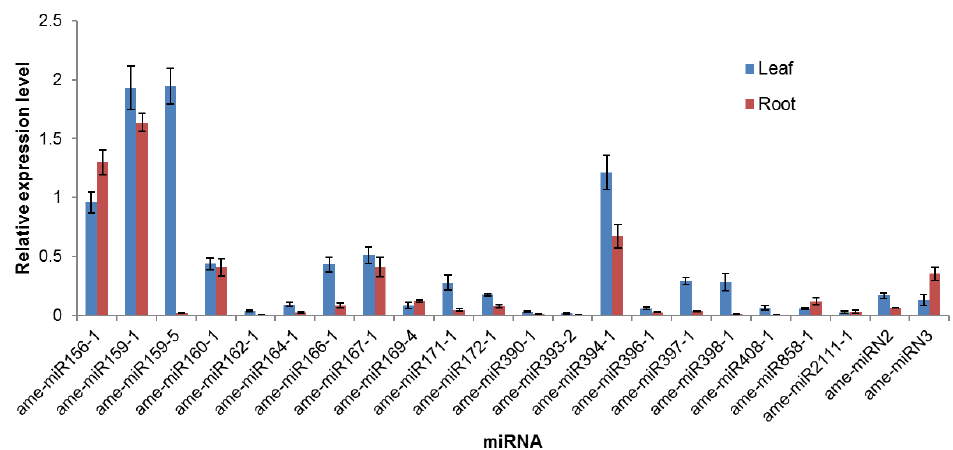
Figure 5. Expression of selected miRNAs in A. membranaceus leaves and roots. The expression level of each miRNA was normalized to that of U6. Error bars indicate SD between replicates.